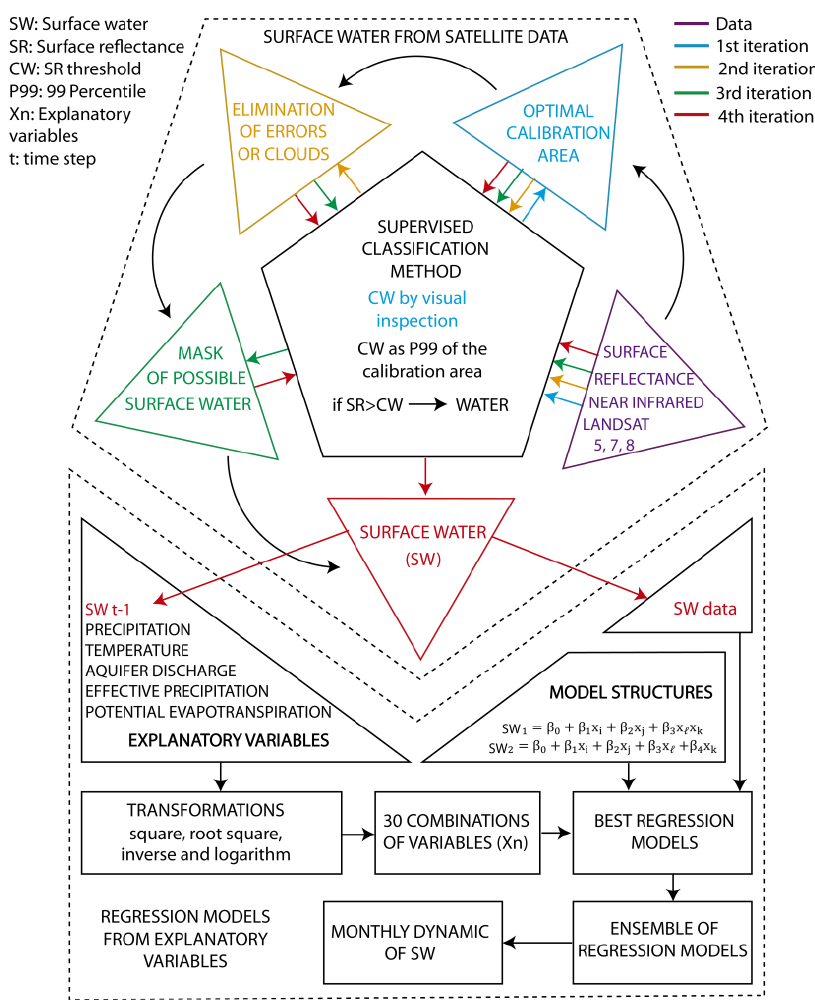
Figure 2. Flow chart of the proposed methodology.